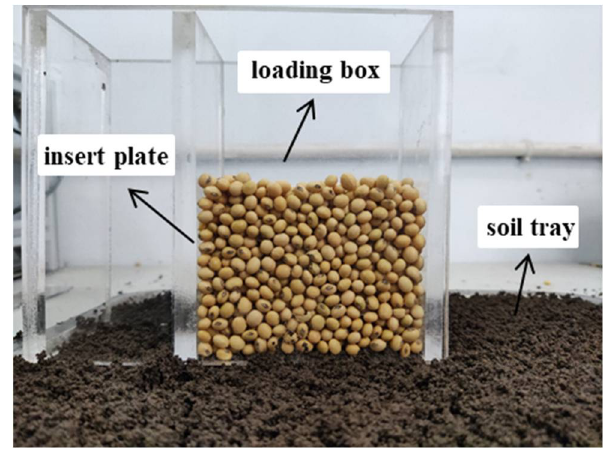
Figure 2. Piling test device.